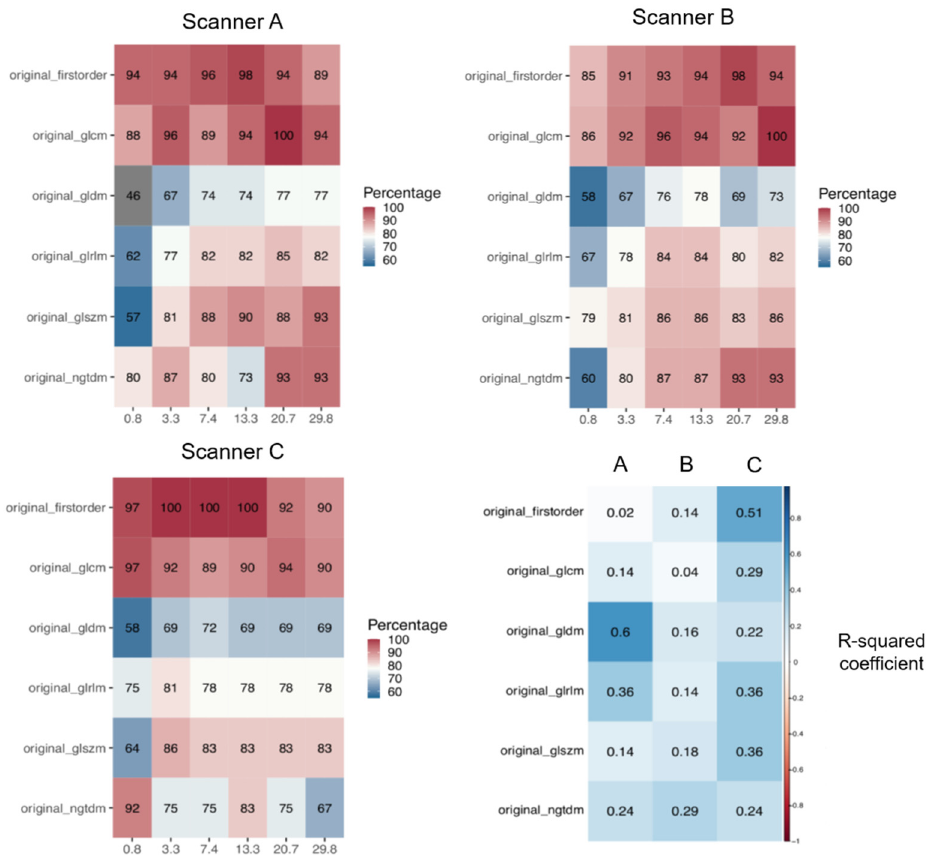
Figure 5. Overall percentage of features discriminative at different volumes for each feature class extracted from the original images in scanners A (top left), B (top right), and C (bottom left). At bottom right, coefficient of determination, R-squared, of the percentage of discriminative features explained by the volume for each scanner.